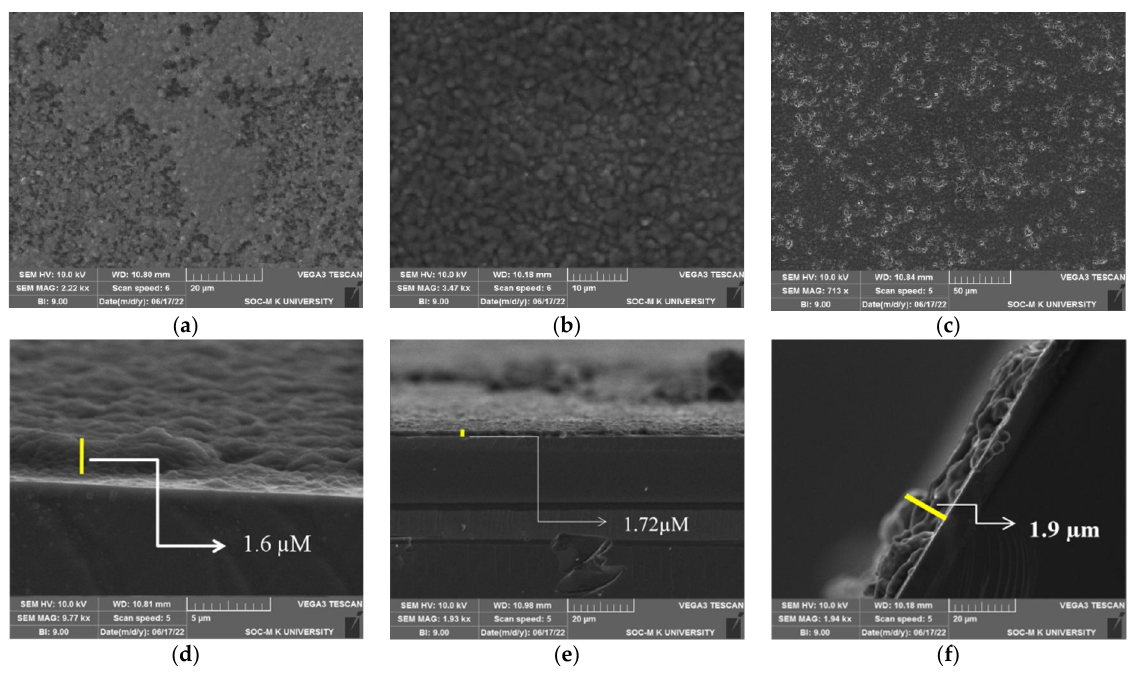
Figure 4. SEM images and cross-section image of the carbon-containing n-type silicon wafer coated with PEDOT: PSS using ( a , d ) ethylene glycol; ( b , e ) acetonitrile; and ( c , f ) DMSO solvent.